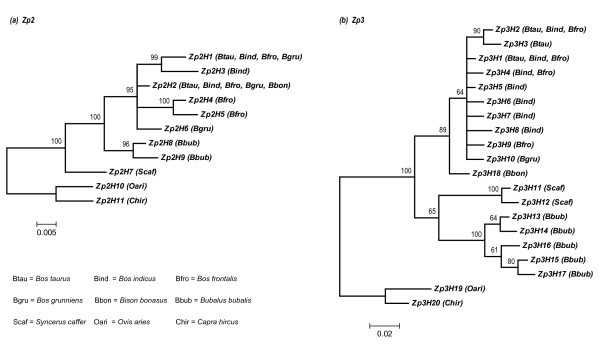
The Bayesian trees of the Zp2 (a) and the Zp3 (b) haplotype sequences from seven species of the Bovini tribe. The haplotype sequences include both coding and non-coding parts. The domestic sheep and goat are used as the outgroup species. Numbers above nodes indicate posterior probability values.